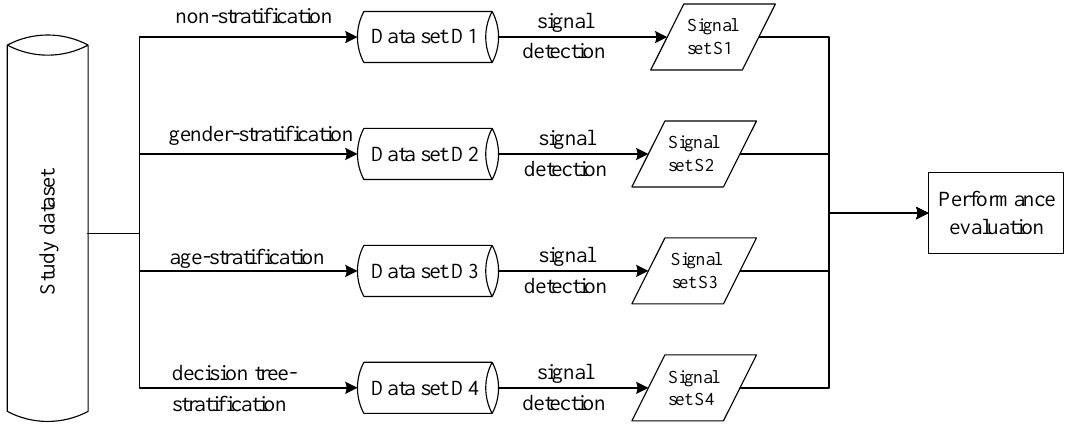
Figure 1. Overall research framework.